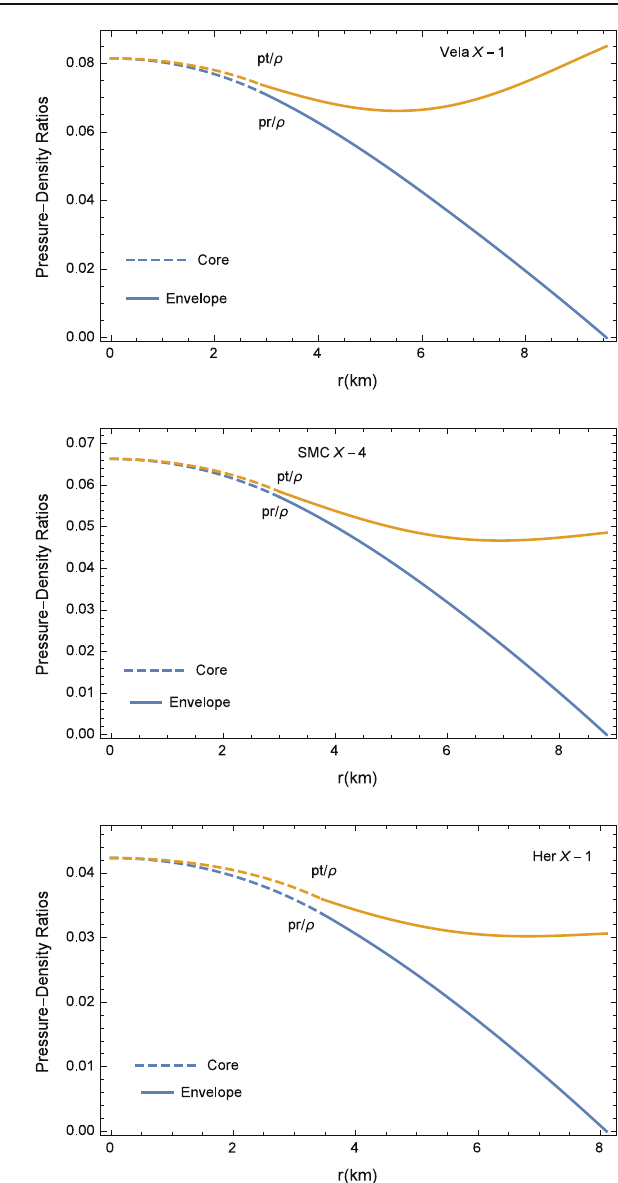
Fig. 3 Variation of pressures with radial coordinate r for ((i) the neu- tron star in Vela X-1(upper) (ii) SMC X-4 (middle) (iii) Her X-1 (lower)